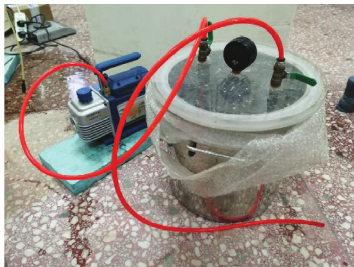
Figure 2: Vacuum saturation.